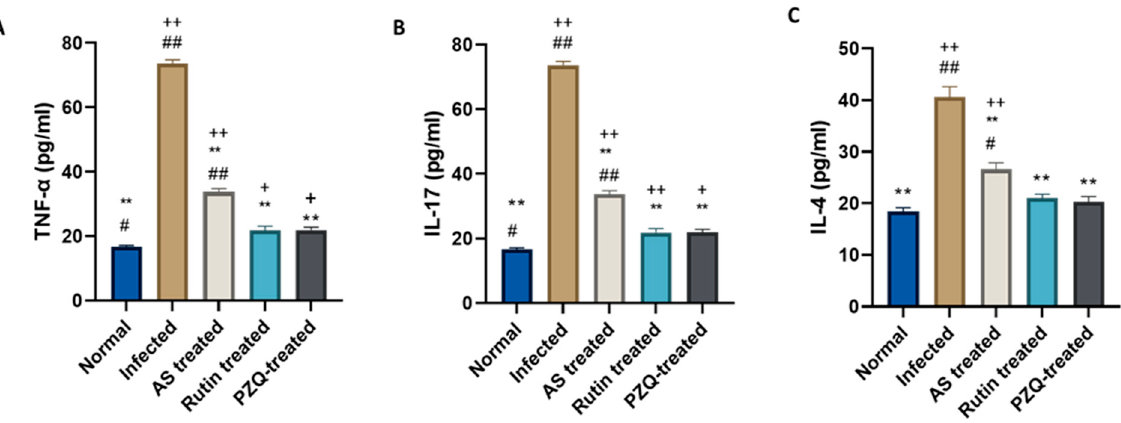
Figure 4. Effect of treatment with rutin naturally isolated from A. sativum on serum cytokines. Effect of different treatments on ( A ) TNF- α , ( B ) IL-17, ( C ) IL-4. Data expressed as mean ± SE ( n = 10). P - value represented the relationship between ASb- and rutin-treated groups and normal control, S. mansoni -infected controls and drug controls. * p < 0.05, ** p -value < 0.001, compared with infected control group; + p < 0.05, ++ p -value < 0.001 in comparison to normal control group; # p < 0.05, ## p - value < 0.001 in comparison to PZQ control group.